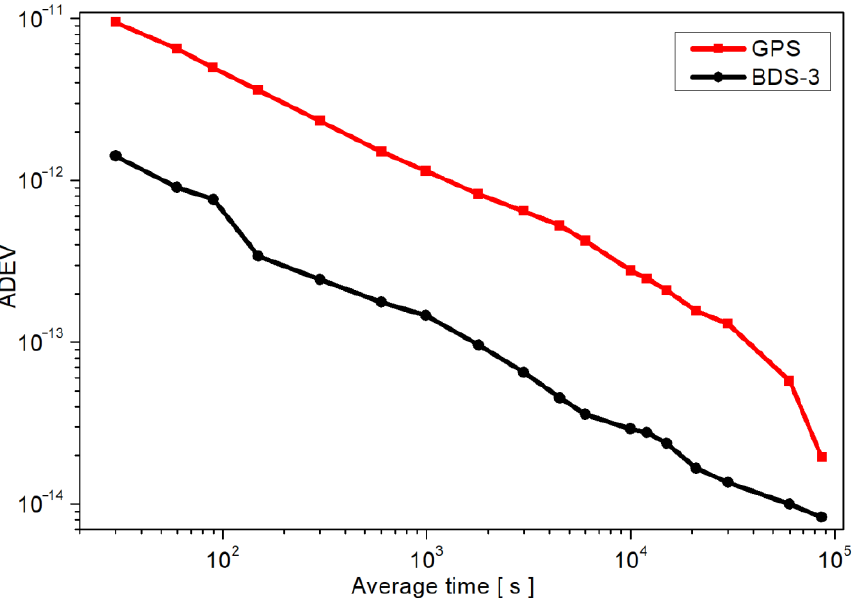
Figure 9. Allan deviation of lck4 receiver clock series from PPP one-way timing from MJDN 59119 to 59126, with products of PPP-B2b.